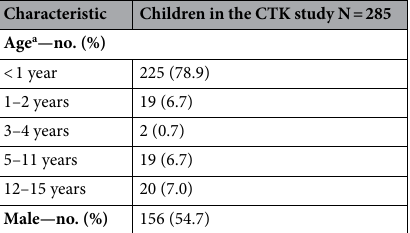
Table 1. Characteristics of the eligible children, 2012–2013. a The child’s age was calculated as the age at visit where there was only one, or the midpoint of the child’s age at her first and last GORD visit, where there was more than